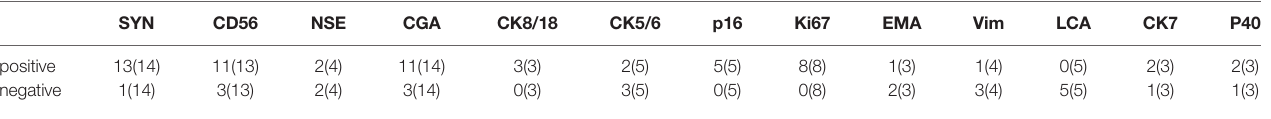
TABLE 4 | Immunohistochemistry.